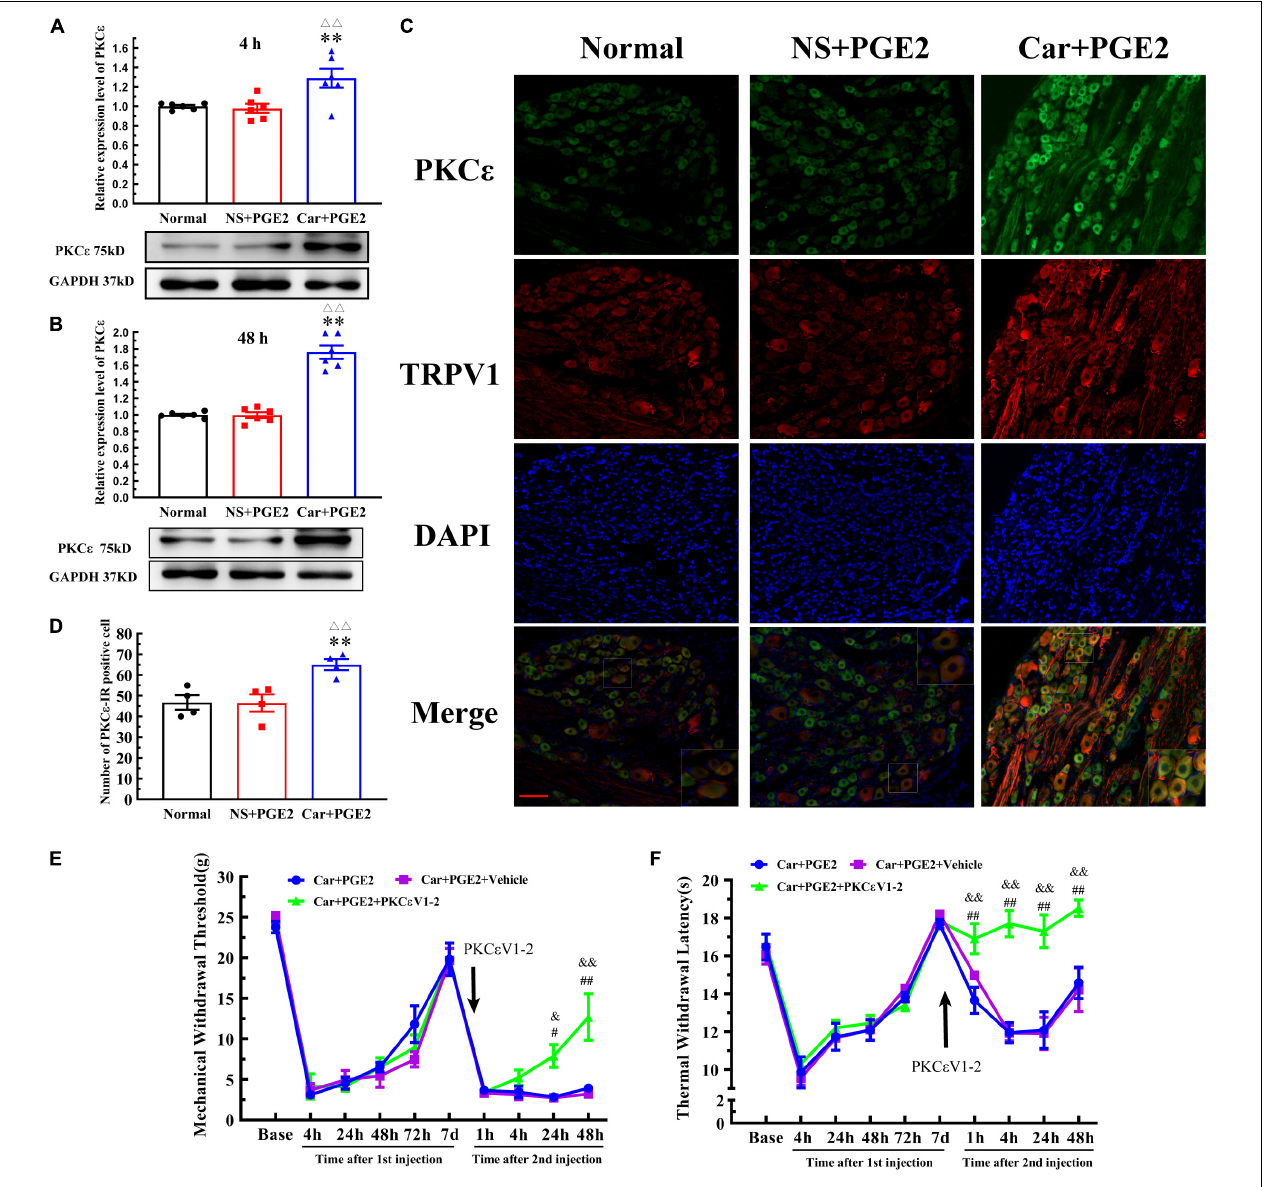
FIGURE 2 | Protein kinase C epsilon (PKC ε ) in the dorsal root ganglion (DRG) plays a pivotal role in the transition from acute to chronic pain. (A) The quantification of the Western blot results and a representative Western blot showing PKC ε protein isolated from the DRG 4 h after PGE2 injection. (B) The quantification of the Western blots results and a representative Western blot showing PKC ε protein isolated from the DRG 48 h after PGE2 injection. (C) PKC ε and TRPV1 staining in the peripheral nervous system 48 h after PGE2 injection. Scale bar 100 µ m. (D) The quantification of PKC ε –IR positive neurons. Mechanical (E) and thermal (F) responses of hyperalgesia model animals that received PKC ε V1-2 injection. n = 6. **Compared with the normal group, P < 0.01; (cid:52)(cid:52) compared with the NS+PGE2 group, P < 0.01; # , ## compared with the Car+PGE2 group, P < 0.05 and P < 0.01, & , && compared with the Car+PGE2+vehicle group, P < 0.05, P <